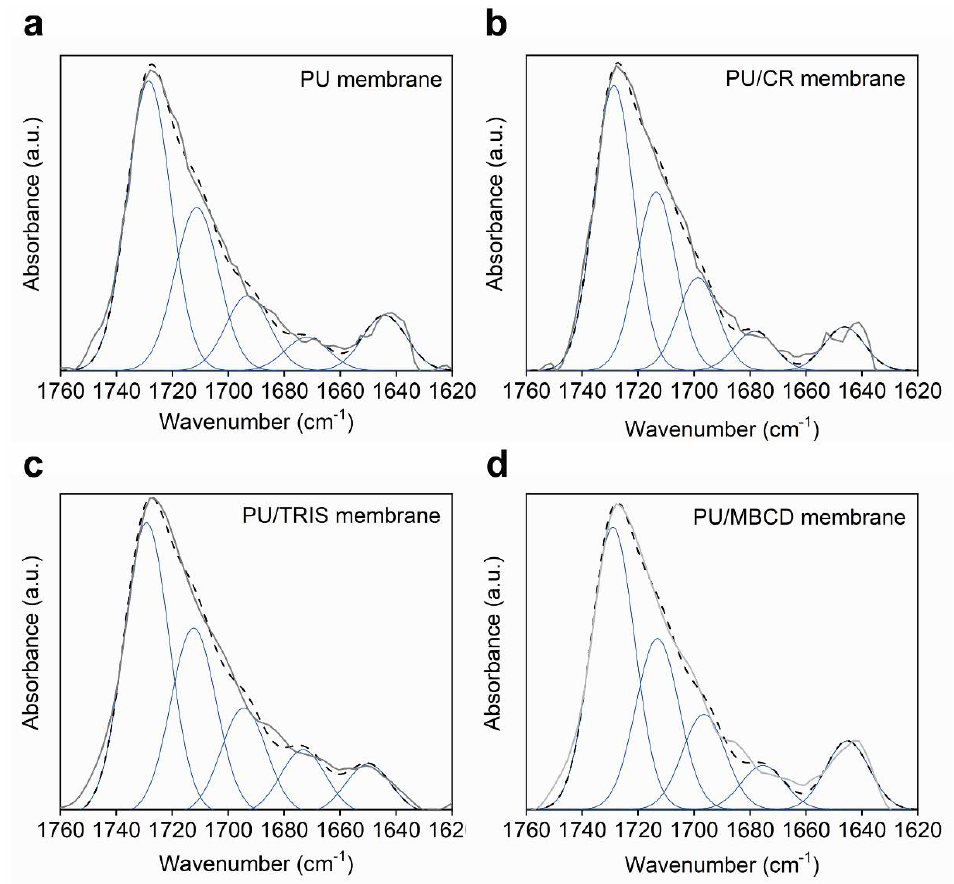
Figure 6. Curve-fitting decomposition of the carbonyl stretching band of the spectra obtained from the ( a ) PU, ( b ) PU/CR, ( c ) PU/TRIS and ( d ) PU/MBCD membranes. ATR-FTIR original spectra are shown by the thick grey line and the simulated band by the dashed line. Table 1. Frequency (υ) and relative area (A) of the regions of the C=O stretching band. Urethane Urea Disordered Ordered H-Bonded H-Bonded Free H-Bonded Free H-Bonded